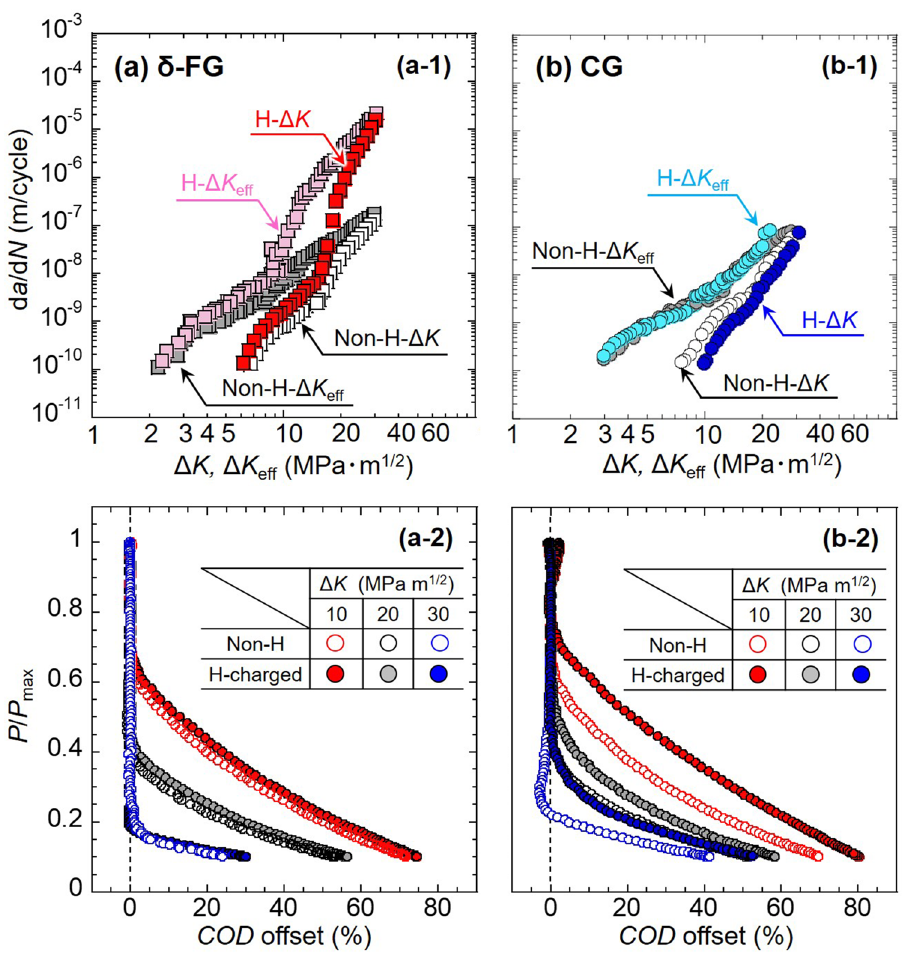
Figure 6. The FCG rate, d a /d N , – effective stress intensity factor range, Δ K eff , diagrams, together with the results of the crack closure analyses for ( a ) δ-FG and ( b ) CG. Δ K eff is given by subtracting the stress intensity factor for crack closing, K cl, from the maximum stress intensity factor, K max . The K cl is provided by the closure analyses in the “Method” section. Crack closure propensity on the relationship between load and compliance offset by Eq. (1) at Δ K = 10, 20, and 30 MPa m 1/2 for ( a-1 ) δ-FG and ( b-1 ) CG. Load is divided by its maximum value. Solid and hollow marks denote the datasets for H-charged and non-charged specimens,